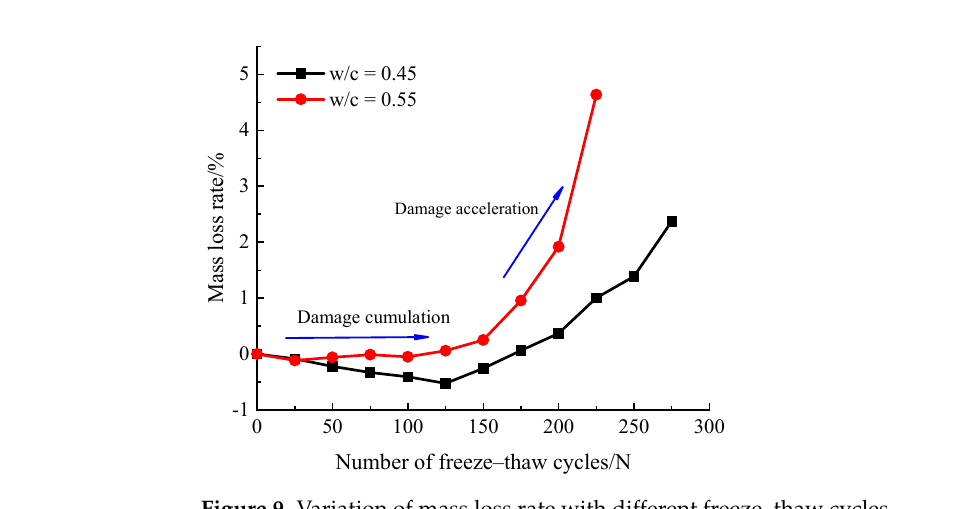
Figure 9. Variation of mass loss rate with different freeze–thaw cycles.